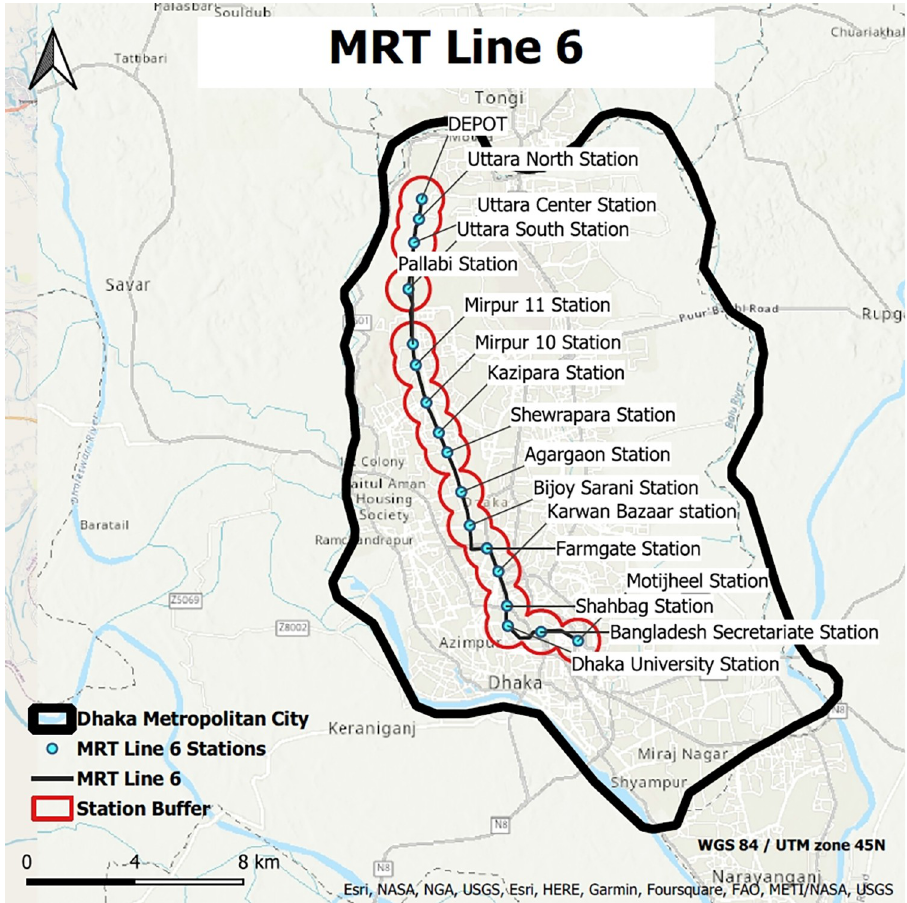
Fig 5. MRT line 6 with 17 stations (source: Map is prepared by authors using base map from https://apps. nationalmap.gov/viewer). Figure is similar but not identical to the original image and is therefore for representative purposes only.